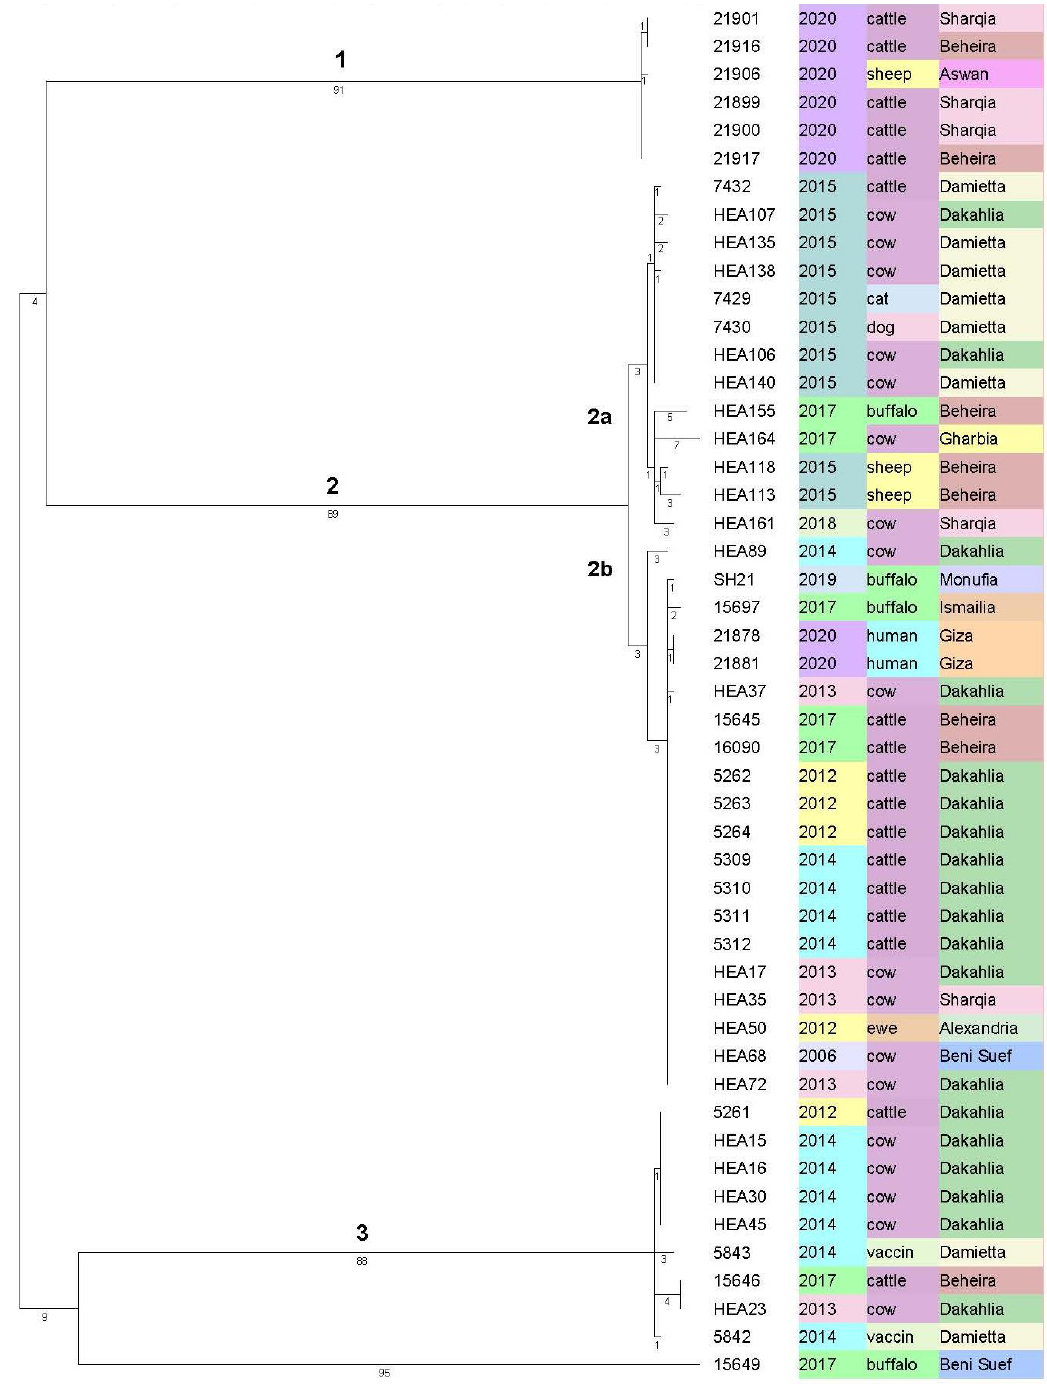
Figure 2. Maximum Parsimony tree for the 45 B. abortus field isolates plus two human isolates and two vaccine batches. The tree is based on WGS core genome SNP analysis and was calculated in Bionumerics with 1000 permutations to get the highest resampling support and rooted by maximum branch length. B. abortus 2308 was set as reference. The three columns represent the year of isolation, the host and the governorate, correspondingly. This automatically generated picture from Bionumerics has been modified for a better representation by Adobe Acrobat Pro 2017. Cluster 1 comprises six isolates from sheep and cattle. All were isolated in 2020. Three isolates share the same cgSNPGT while three more isolates differ in one cgSNP from the former three. Five of these isolates are from Beheira and Sharqia (170 km distance) in